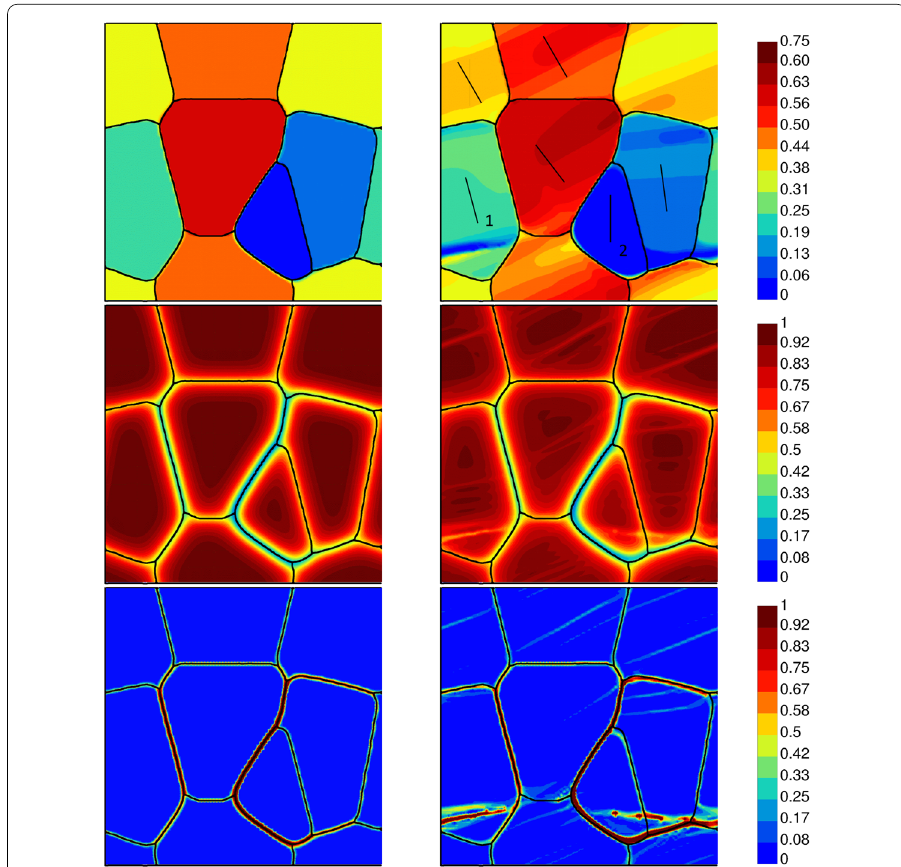
Fig. 3 The six grain microstructure before and after applied shear deformation. The initial values are shown to the left for θ (top), φ (middle) and norm of the curvature |∇ θ | (bottom). Top right shows the orientation distribution after shear deformation, middle right shows the corresponding phase-field φ and bottom right shows the norm of the curvature. The true maximum value of the curvature norm is around |∇ θ | = 1 . 9 µ m − 1 but it has been capped off at 1 µ m − 1 for a better visualization. In the simulation, only one slip system α = 2 was active, resulting in the formation of kink bands and subgrains. The slip direction of each grain is indicated with black lines in the top right figure